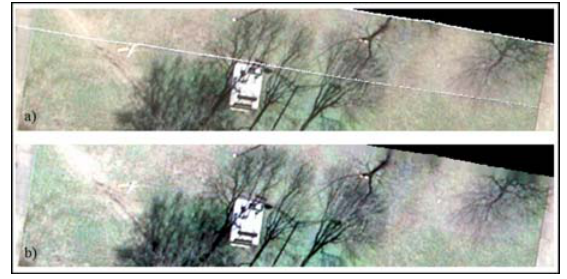
Figure 4. Occlusion recovery a) without and b) with trimming